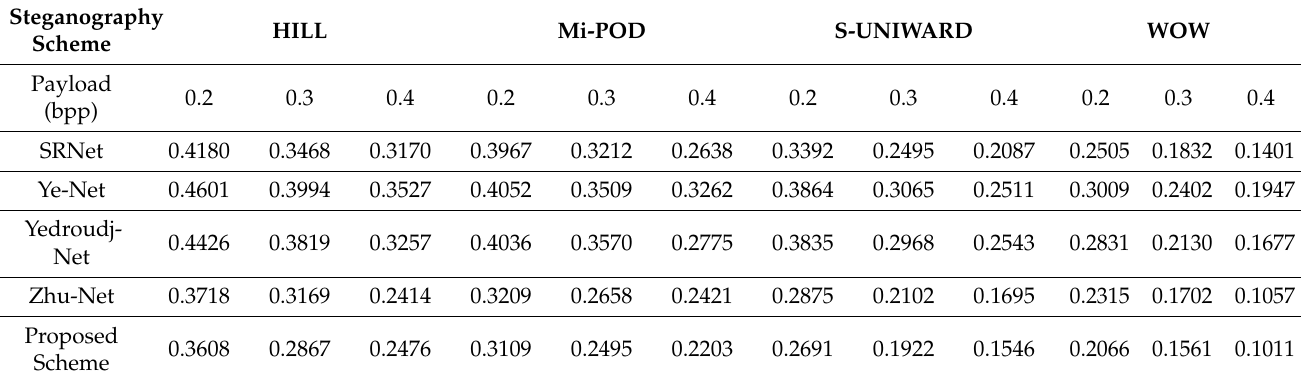
Table 7. Detection errors of proposed and other schemes using BOWS2 and BOSSBase image